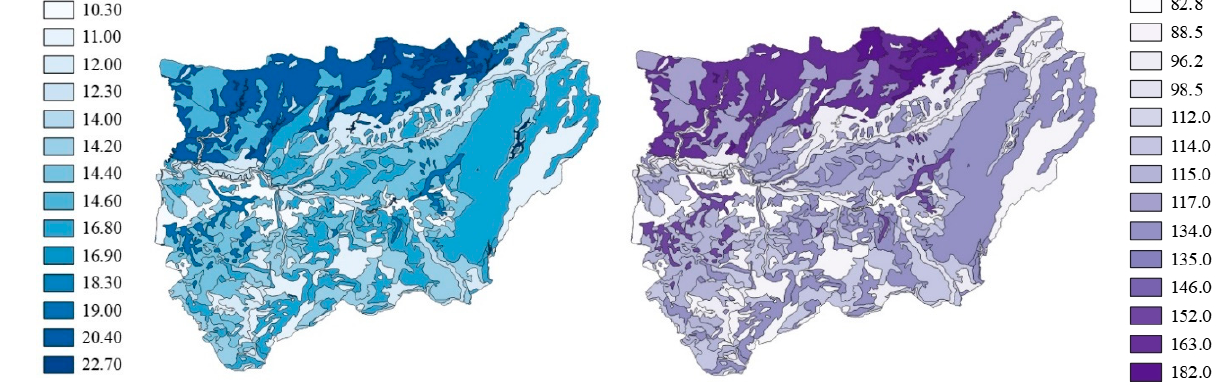
Figure 11. Spatial distribution and values of useful water (AWI) and usable water (SWRC).